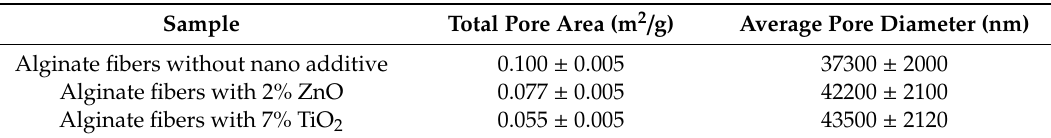
Table 2. Porosity of obtained fibers.